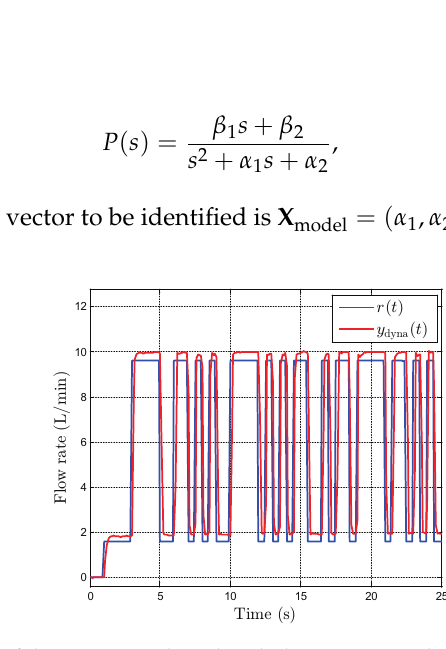
Figure 7. Output y dyna ( t ) of the EHVS combined with the inverse model ˆ Φ − 1 [ r ]( t ) excited by the PRBS signal r ( t ) .